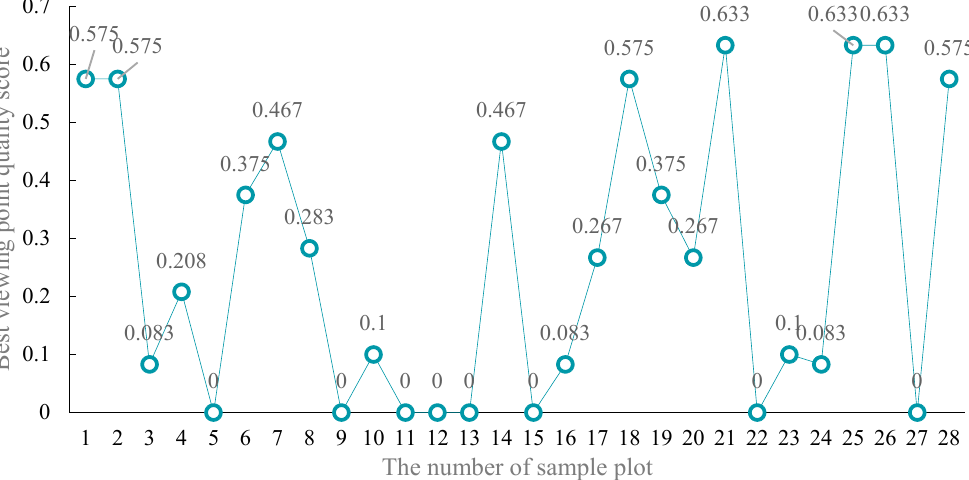
Figure 7. The score value of the best ornamental point quality in the sample sites.